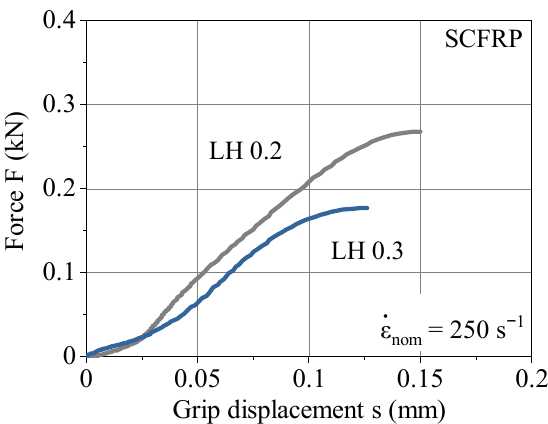
Figure 11. Force vs. grip displacement for LH 0.2 and LH 0.3 at a strain rate of 250 s − 1 .